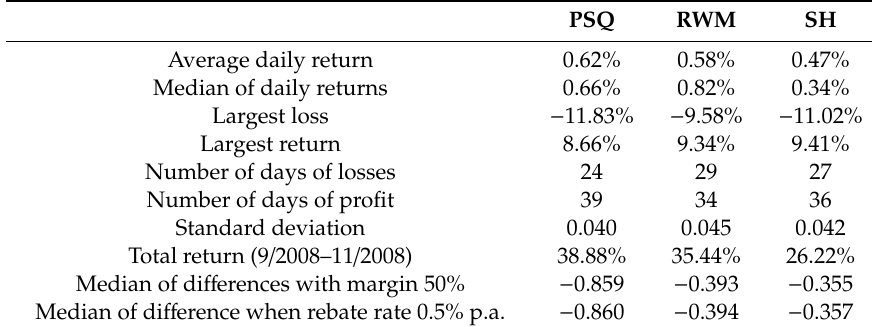
Table 4. Characteristics of daily returns of inverse ETFs in the period 9 / 2008–11 / 2008 and di ff erences from short sales